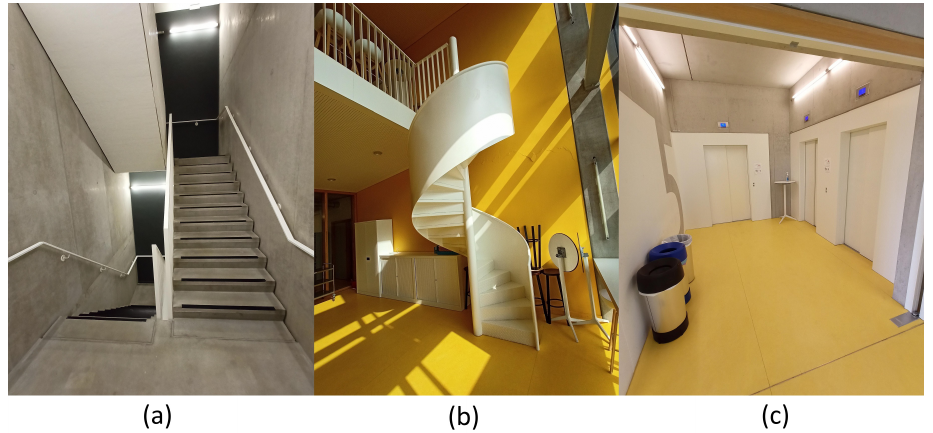
Figure 7. Pictures of one of the staircases in separate stairwells ( a ), the open staircase in the kitchen ( b ) and elevators ( c